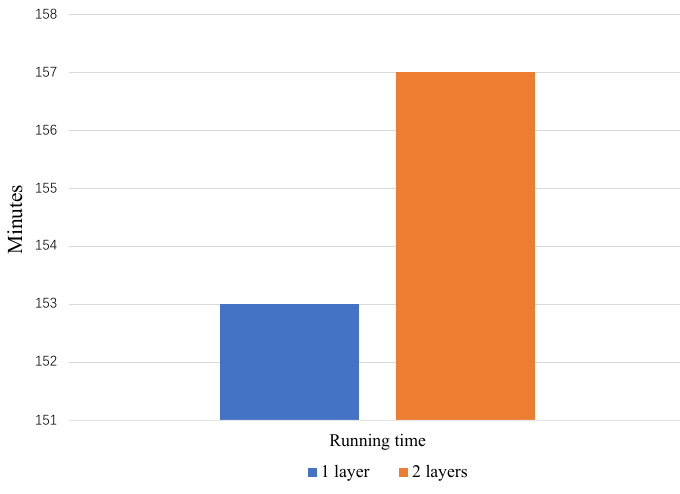
Figure 4. Runtime